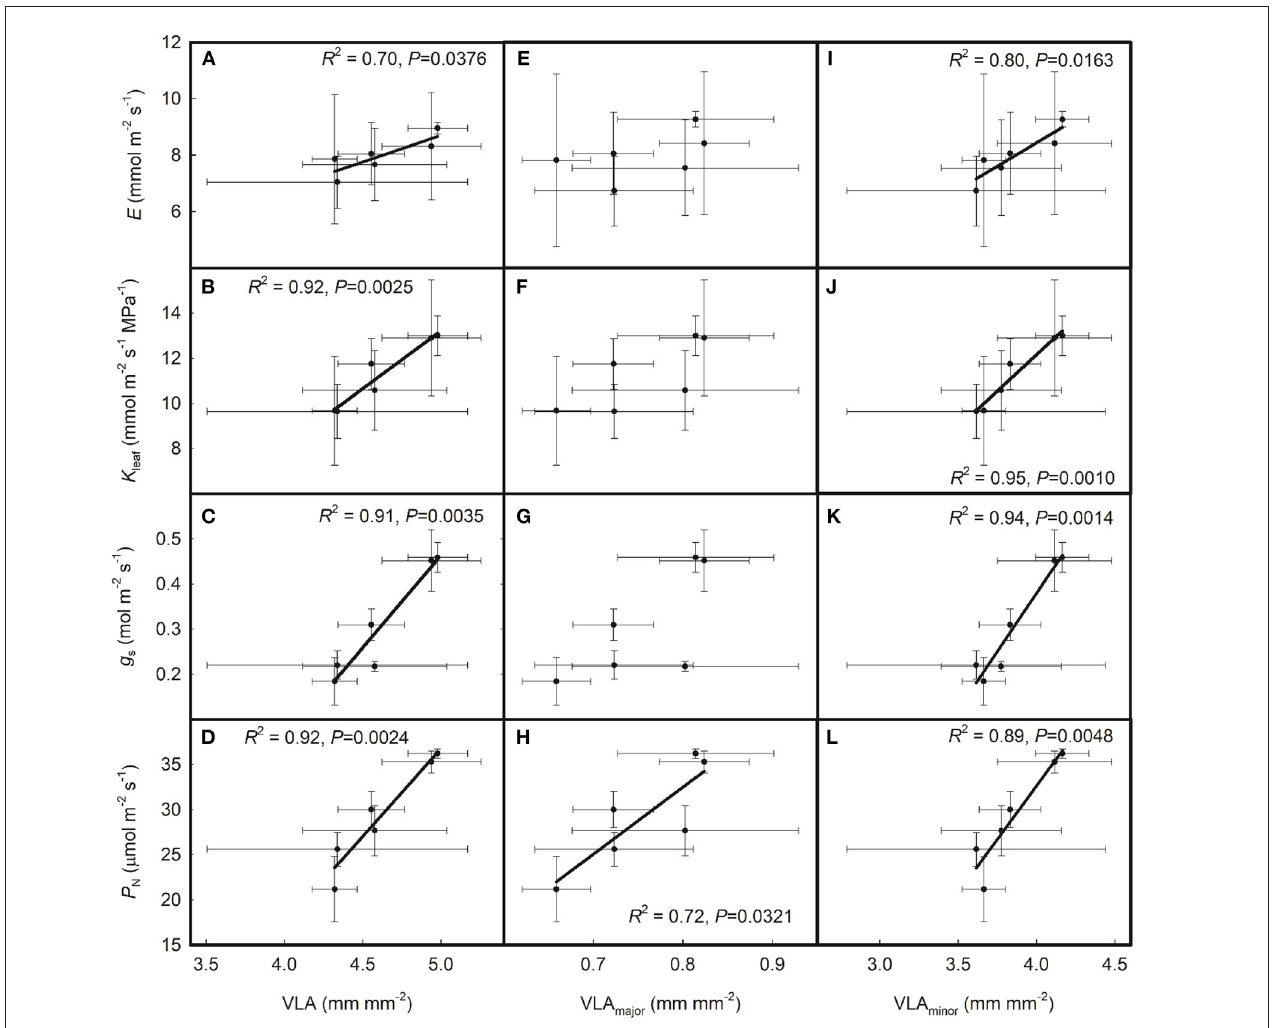
FIGURE 3 | Relationships of the leaf hydraulics and leaf gas exchange parameters with (A–D) total leaf vein density (VLA), (E–H) major leaf vein density (VLA minor ), and (I–L) minor leaf vein density (VLA minor ) across the six rice genotypes. Data are shown as the means ± SD. There were four replicates for leaf vein densities and three replicates for P N , g s , K leaf , and